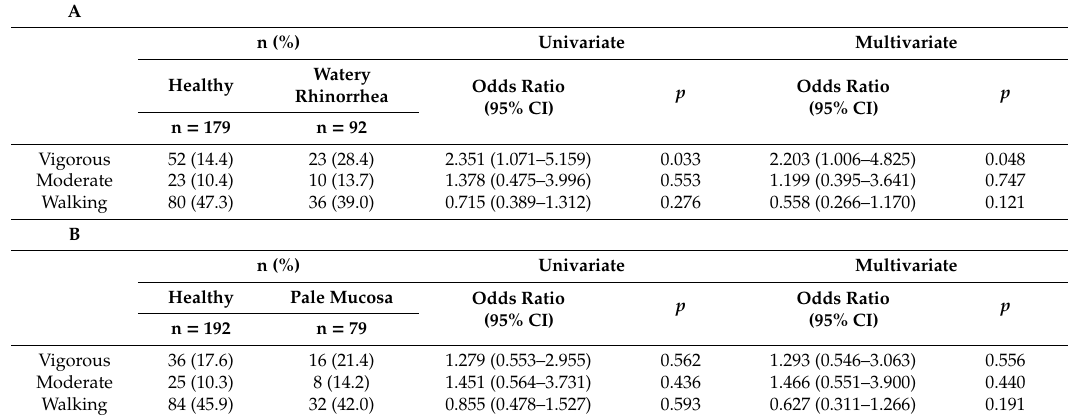
Table 4. Odds ratios for the association between physical activity and (A) watery rhinorrhea or (B) pale mucosa on rhinoscopy in patients with allergic